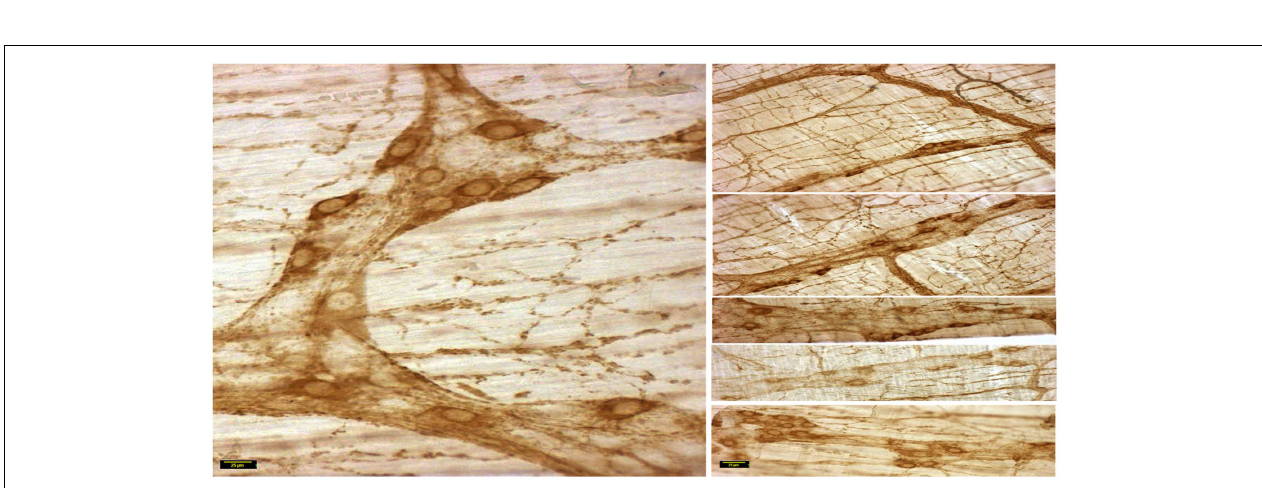
FIGURE 6 | nNOS α expression in vehicle treated jejunum . Note the variance of nNOS expression in the neuronal cell bodies in the segments of the right panels. Scale bar representative of each side, 25 µ m.